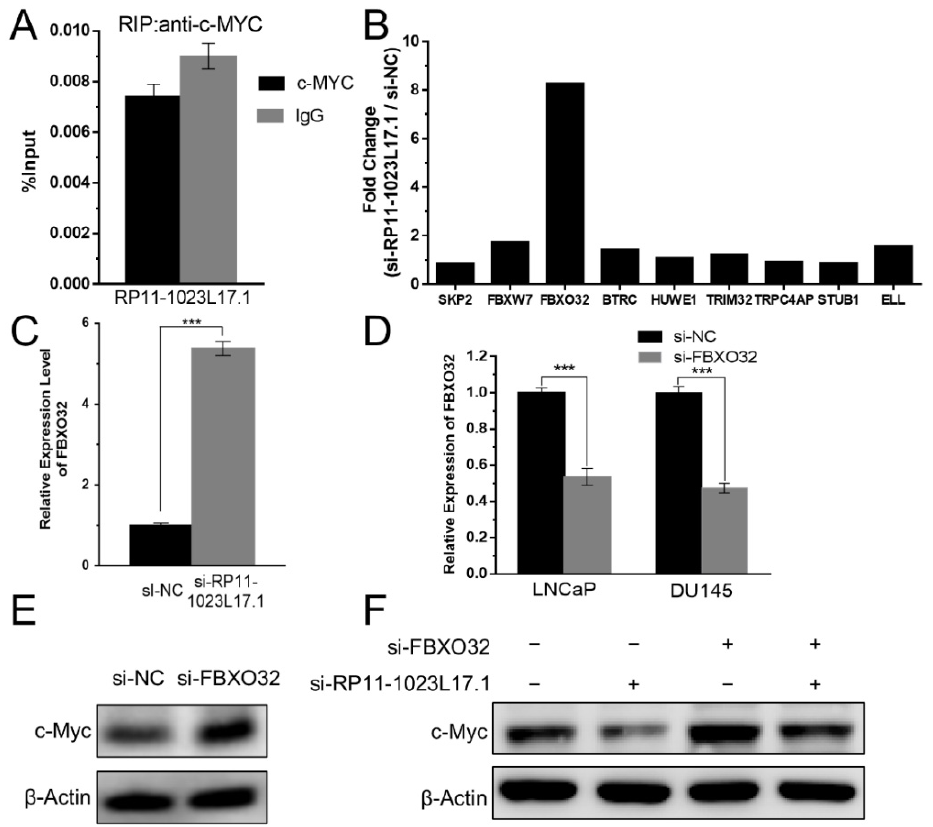
Figure 5. RP11-1023L17.1 inhibits c-Myc protein degradation through the regulation of FBXO32. ( A ) RP11-1023L17.1 was detected in RIP assays using anti-c-Myc or IgG antibodies in LNCaP cells. ( B ) The expression changes of ubiquitin ligase genes that regulate c-Myc stability in